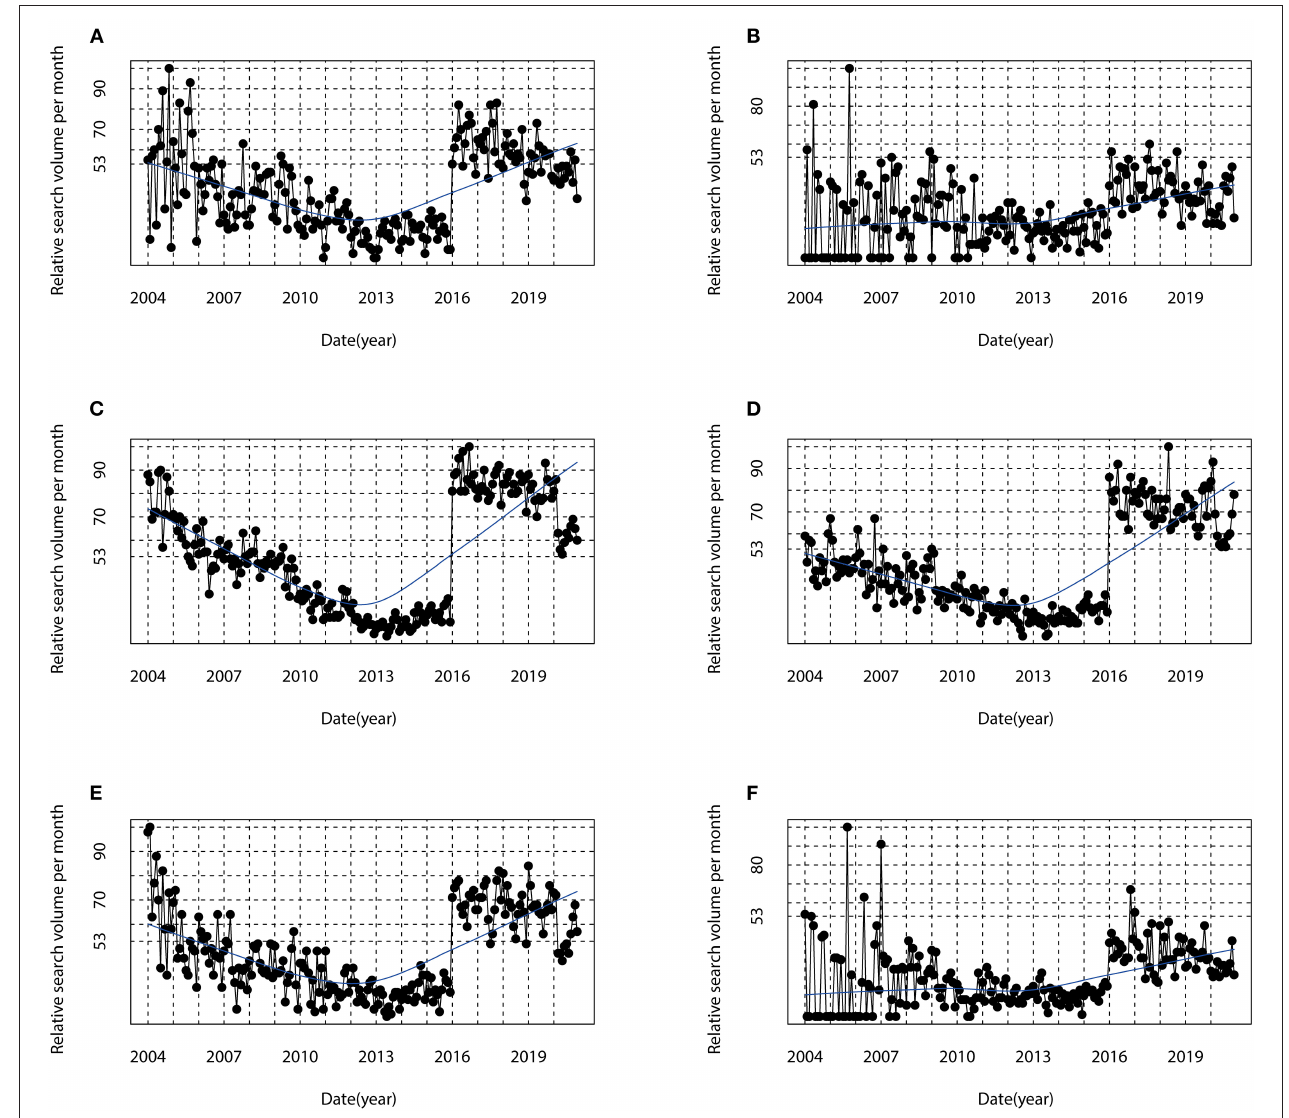
FIGURE 5 | Time series plots for the relative search volume of [Alzheimer’s disease] in (A) Australia, (B) New Zealand, (C) the USA, (D) the UK, (E) Canada, and (F) Ireland from January 2004 to December